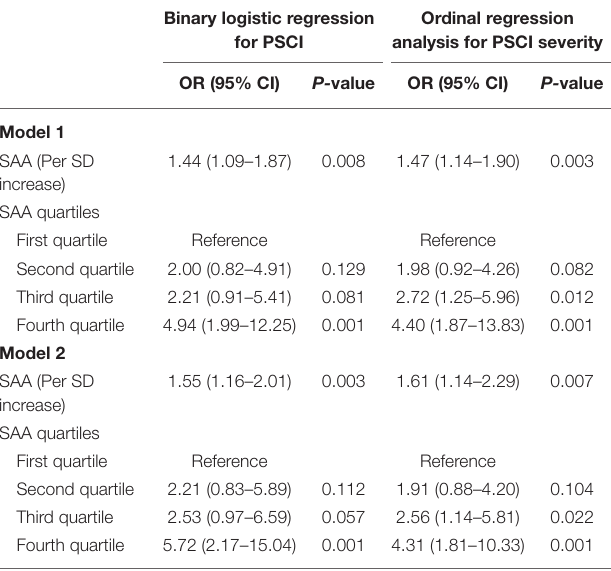
TABLE 2 | Logistic regression analysis for the associations between serum amyloid A (SAA) levels and a clinical outcome.